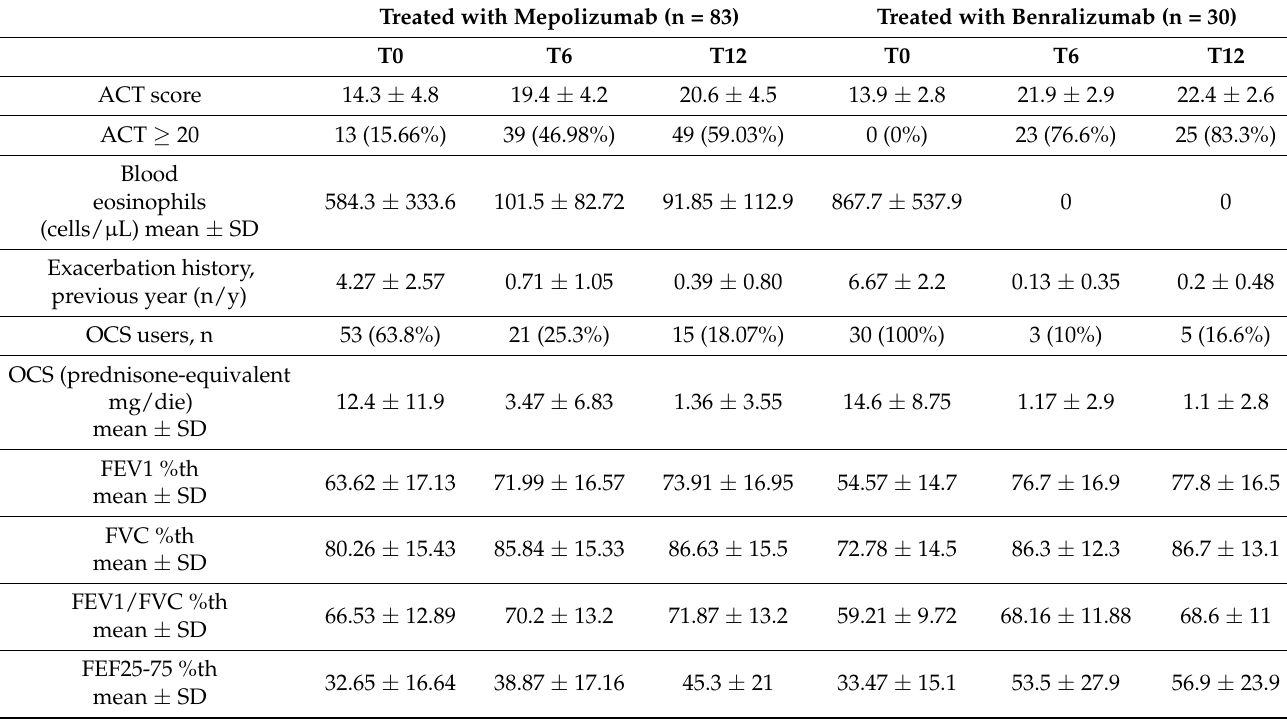
Table 2. Clinical, biological, and functional data of the study population. Treated with Mepolizumab (n = 83) Treated with Benralizumab (n =